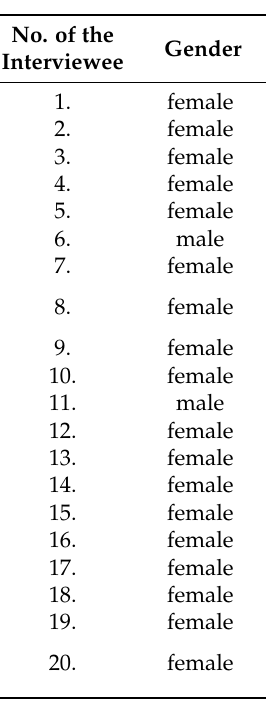
Table 4. Summary data of the